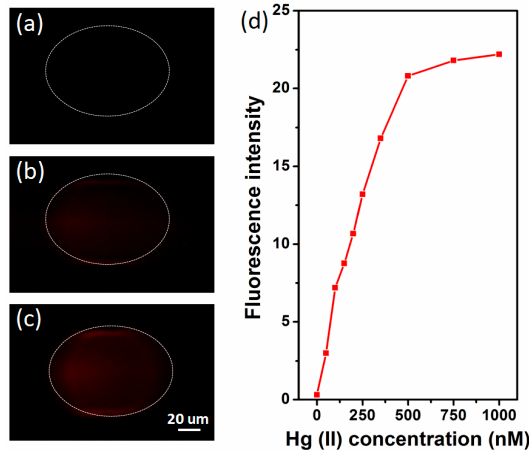
Figure 5. Representative fluorescence images of ( a ) probe (Rhodamine B mixed with AuNPs) droplet, probe droplet with ( b ) 250 nM and ( c ) 1000 nM Hg(II) ions; ( d ) Fluorescence intensity of probe droplet with different Hg(II) ion